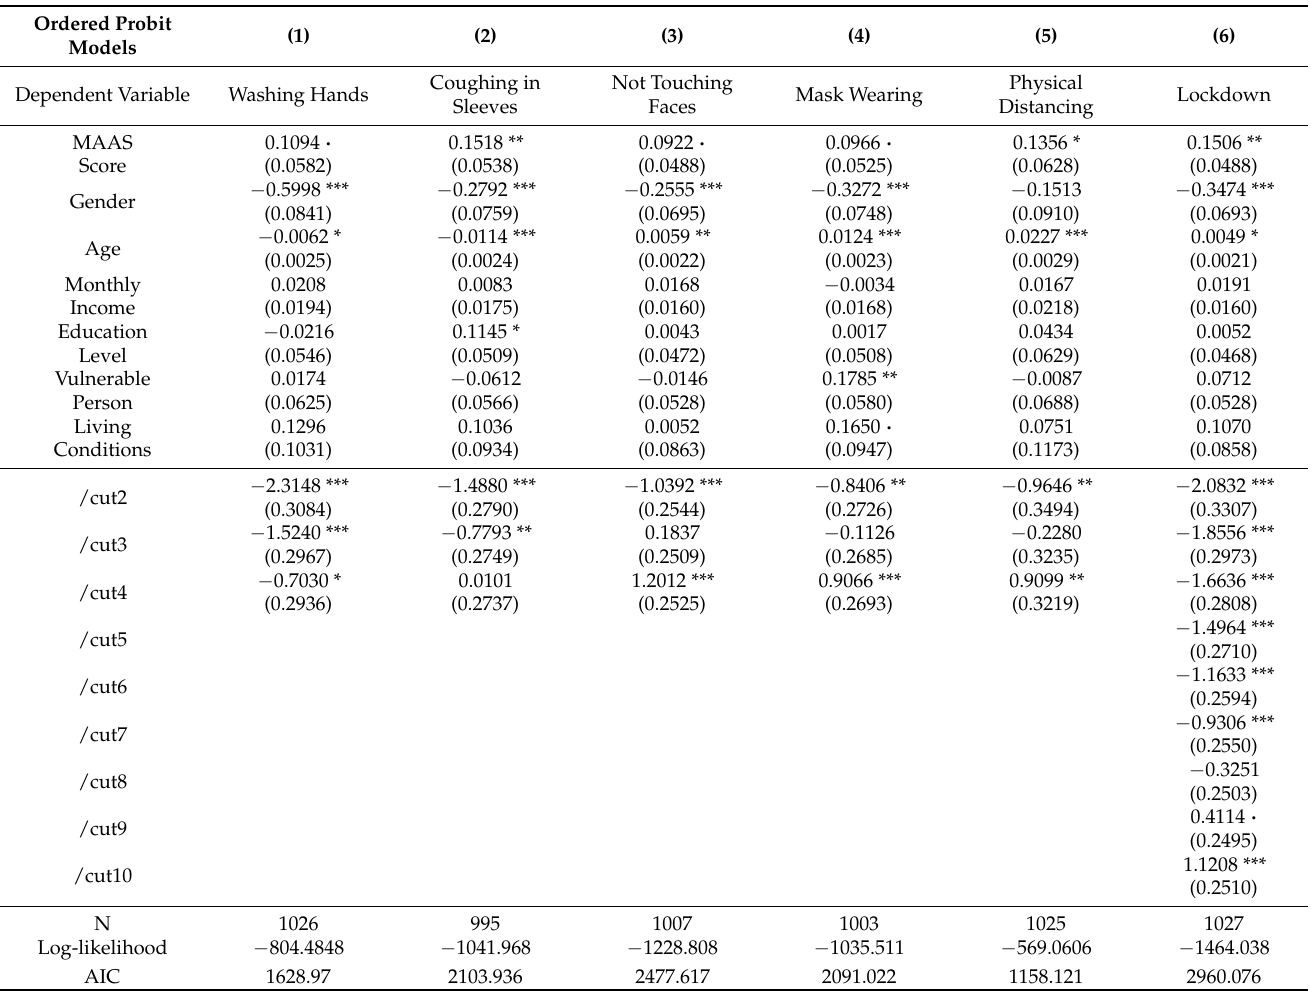
Table 7. Ordered probit regression models for compliant